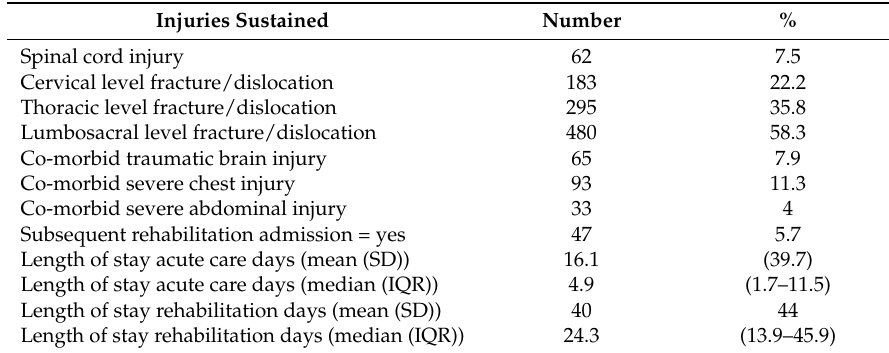
Table 2. Injury detail and consequent hospitalisation.